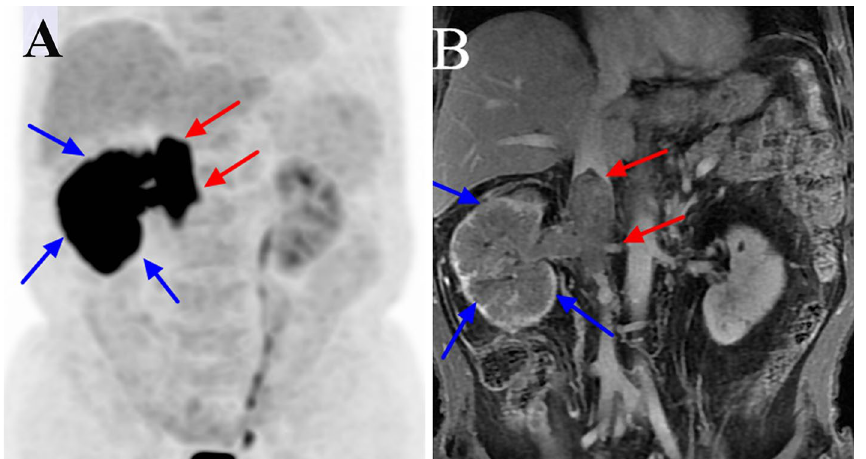
Figure 3. 18 F-FDG PET/CT and contrast-enhanced MRI (CEMRI) scans of a 77-year-old man with papillary cell carcinoma of the right kidney associated with a level II venous tumour thrombus (VTT). The VTT had invaded the venous wall and was graded as level II by PET/CT and CEMRI. The site of diffusely increased FDG uptake (SUVmax 9.6) on the PET maximum intensity projection image is the primary tumour (blue arrow) ( a ). The site of pathologically increased FDG uptake (SUVmax 12.5) from the right renal vein to the inferior vena cava is the VTT (red arrow) ( a ). The VTT had a regular shape, was enhanced and completely occluded the inferior vena cava lumen on coronal CEMRI (red arrow) ( b ), and the primary tumour showed diffuse heterogeneous enhancement (blue arrow) ( b